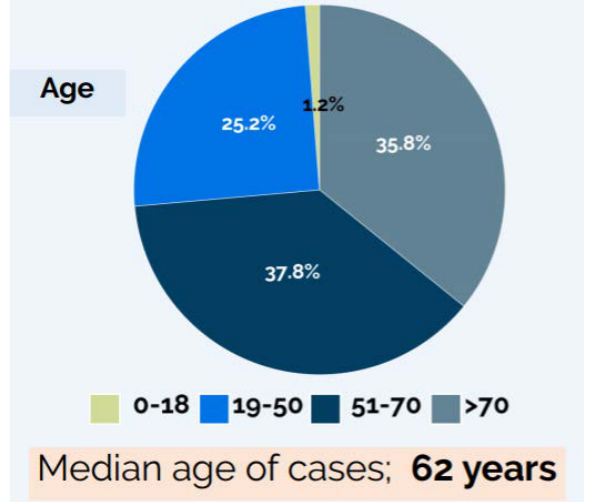
Figure 3. Age distribution of COVID-19 cases—27 March 2020 [15].